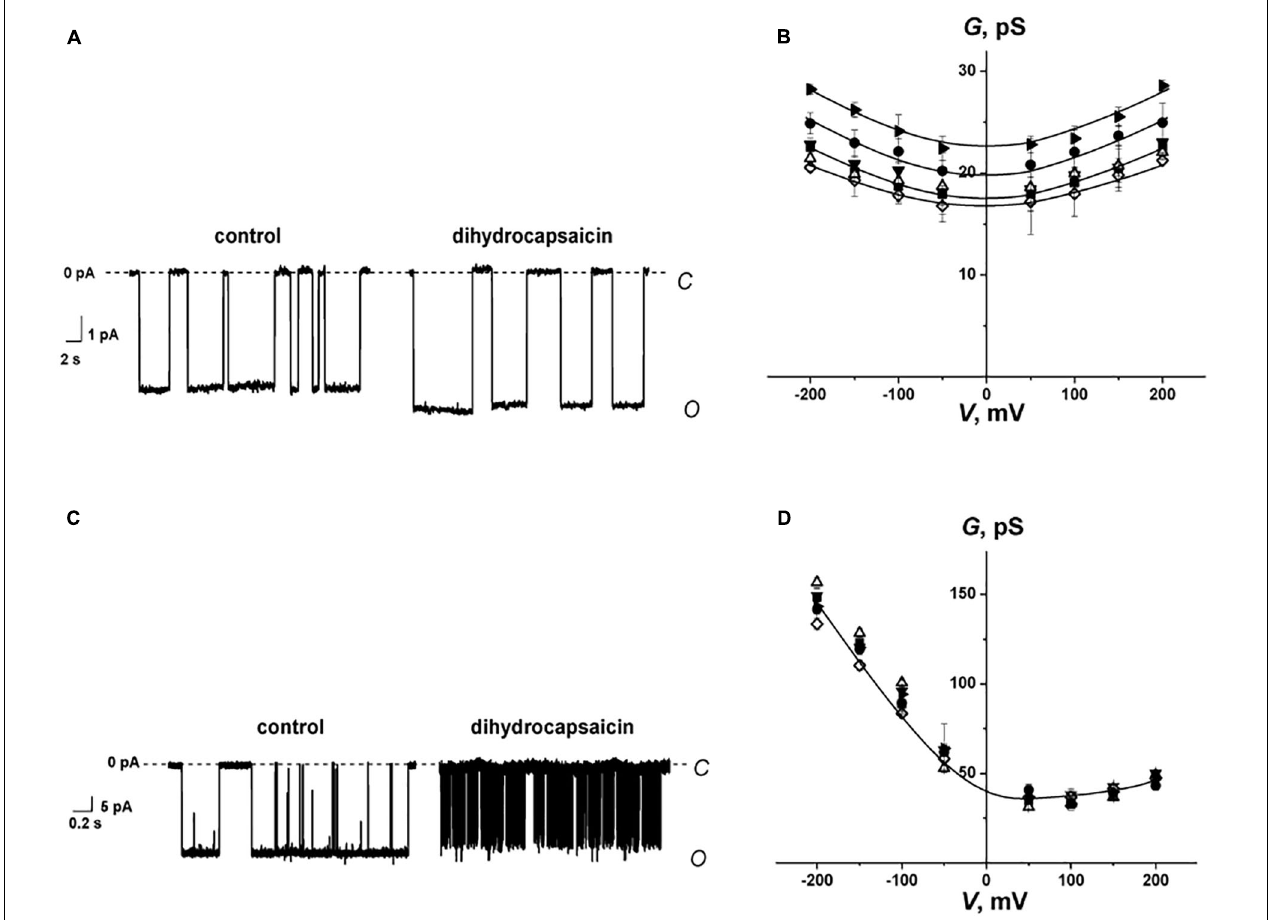
FIGURE 4 | (A,C) Current fluctuations corresponding to the openings and closures of single GrA (A) and SyrE channels (C) in the absence ( control ) and presence of 0.4 mM dihydrocapsaicin. V = − 200 mV. C – closed state of the channel, O – open state of the channel. (B,D) G ( V ) curves of single GrA (B) and SyrE channels (D) in the absence ( (cid:4) ) and presence of 0.4 mM piperine ( ♦ ), pentoxifylline ( (cid:72) ), synephrine ( (cid:49) ), capsaicin ( (cid:32)